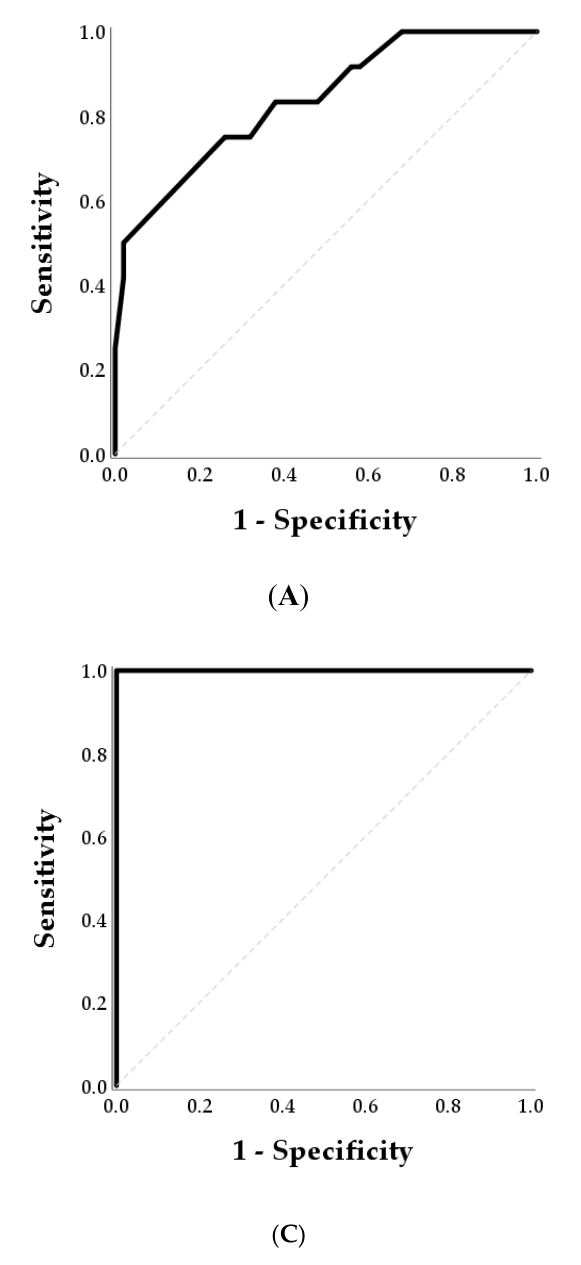
Figure 4. Receiver operating characteristic (ROC) curves for the detection of embryonic mortality by PAG at days 25 (Panel A ), 28 (Panel B ), and 40 (Panel C ) post-AI. Optimal cut-offs for predicting mortality were 1.1 ng/mL, 2.2 ng/mL, and 2.7 ng/mL at days 25, 28 and 40 post-AI, respectively.